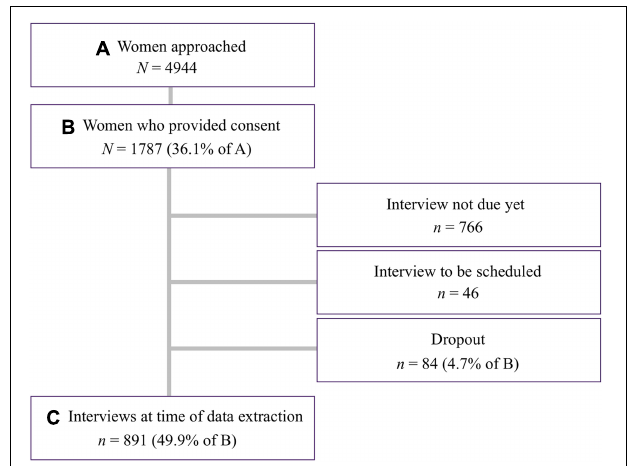
FIGURE 3 | Flow chart of the INVITE study. Data extraction took place on 29 October